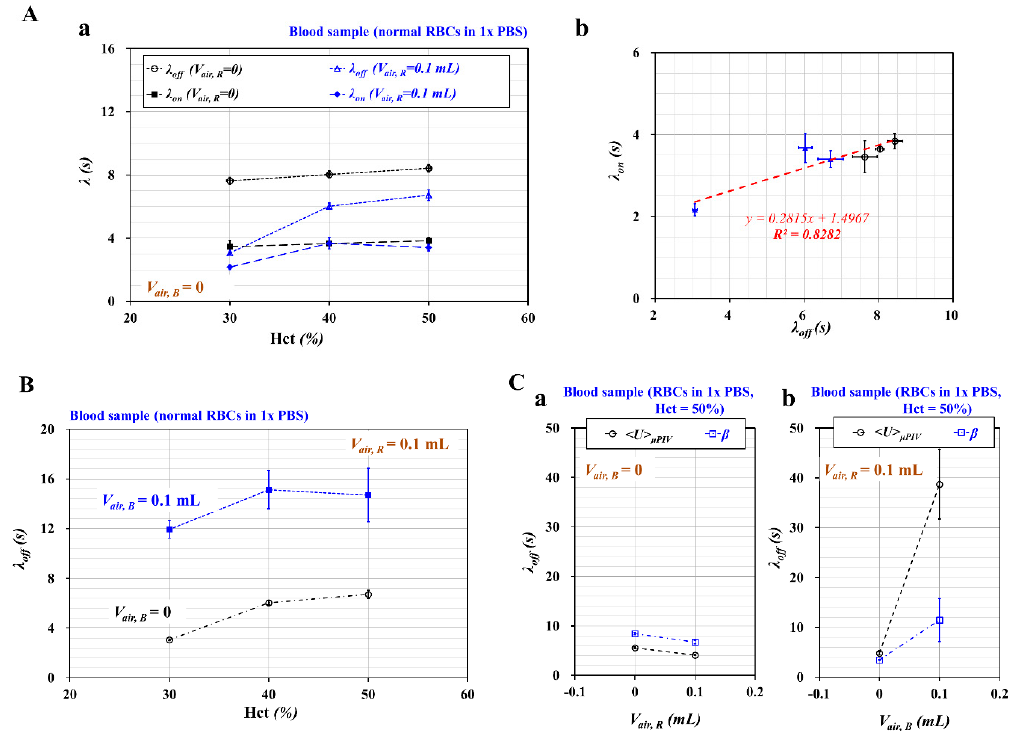
Figure 3. Quantitative evaluations of time constants ( λ o ff , λ on ) with respect to hematocrit and air cavity in each syringe. Here, a blood sample was prepared by adding normal RBCs into 1 × PBS. ( A ) The comparison of two time constants with respect to hematocrit and air cavity. (a) Variations of λ off and λ on with respect to Hct = 30%, 40%, and 50% and V air, R = 0 and 0.1 mL. (b) Linear relationship between λ o ff and λ on . Here, the air cavity in the blood sample syringe was set to zero. ( B ) Variations of λ off and λ on with respect to Hct = 30%, 40%, and 50% with V air, B = 0 and 0.1 mL. Here, the air cavity in the reference fluid syringe was set to 0.1 mL. ( C ) Quantitative comparison of λ o ff obtained from <U> μ PIV and β . The hematocrit of the blood sample was adjusted to Hct = 50% by adding normal RBCs into 1 × PBS. (a) Comparison of λ o ff obtained from < U > µ PIV and β with respect to V air, R = 0 and 0.1 mL. Here, the air cavity in the blood sample syringe was set to zero. (b) Comparison of λ o ff obtained from <U> μ PIV and β with respect to V air, B = 0 and 0.1 mL. Here, the air cavity in the reference fluid syringe was set to 0.1 mL.